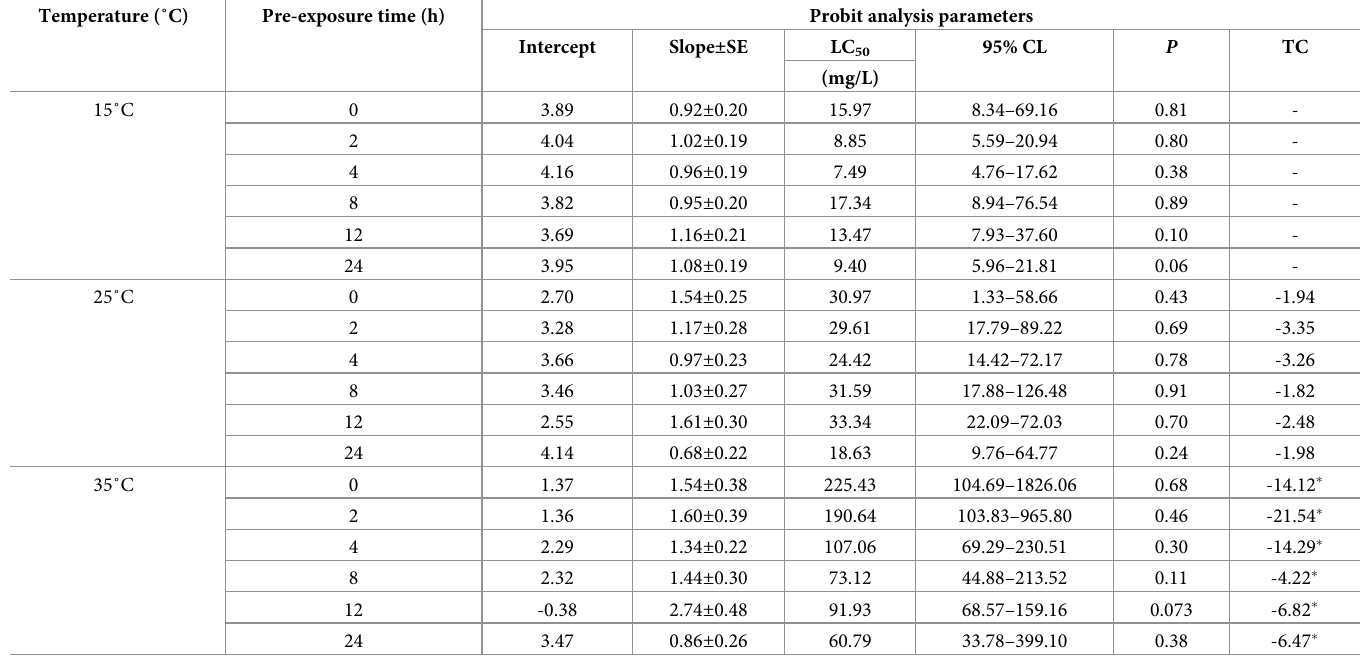
Table 2. Influence of pre-exposure time on the toxicity of negative temperature effect insecticide β -cypermethrin to A . lucorum at 15, 25, 35˚C. Temperature (˚C)